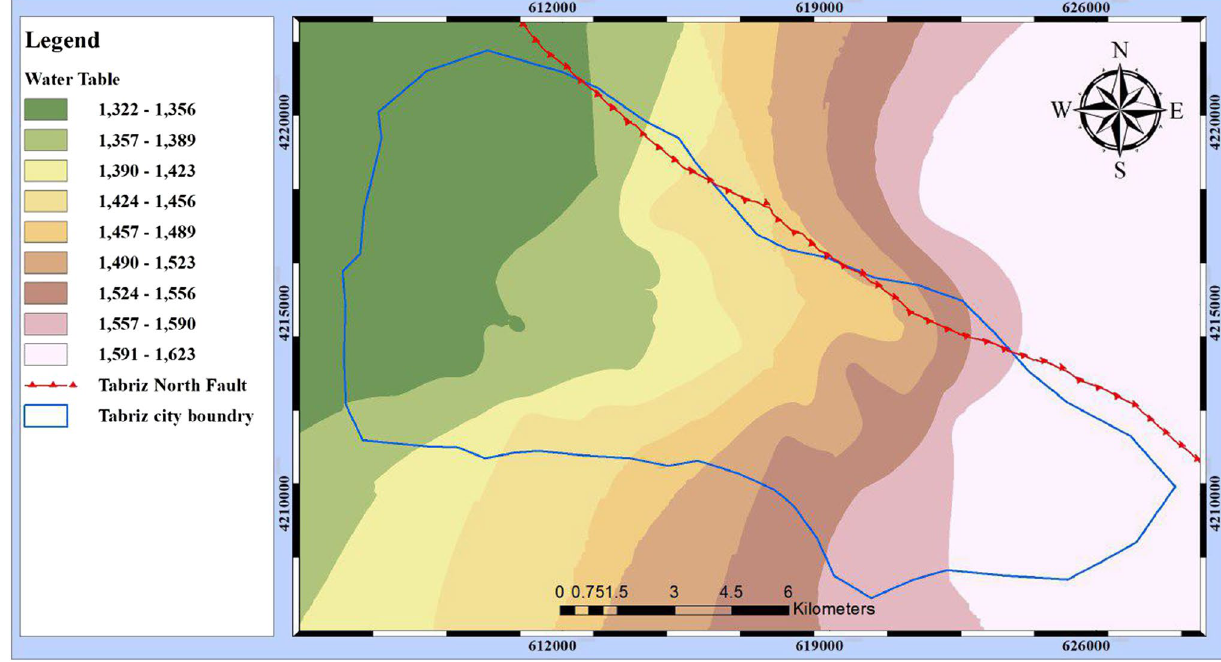
Fig. 2 Variations of the water table in depth below the ground level in the study